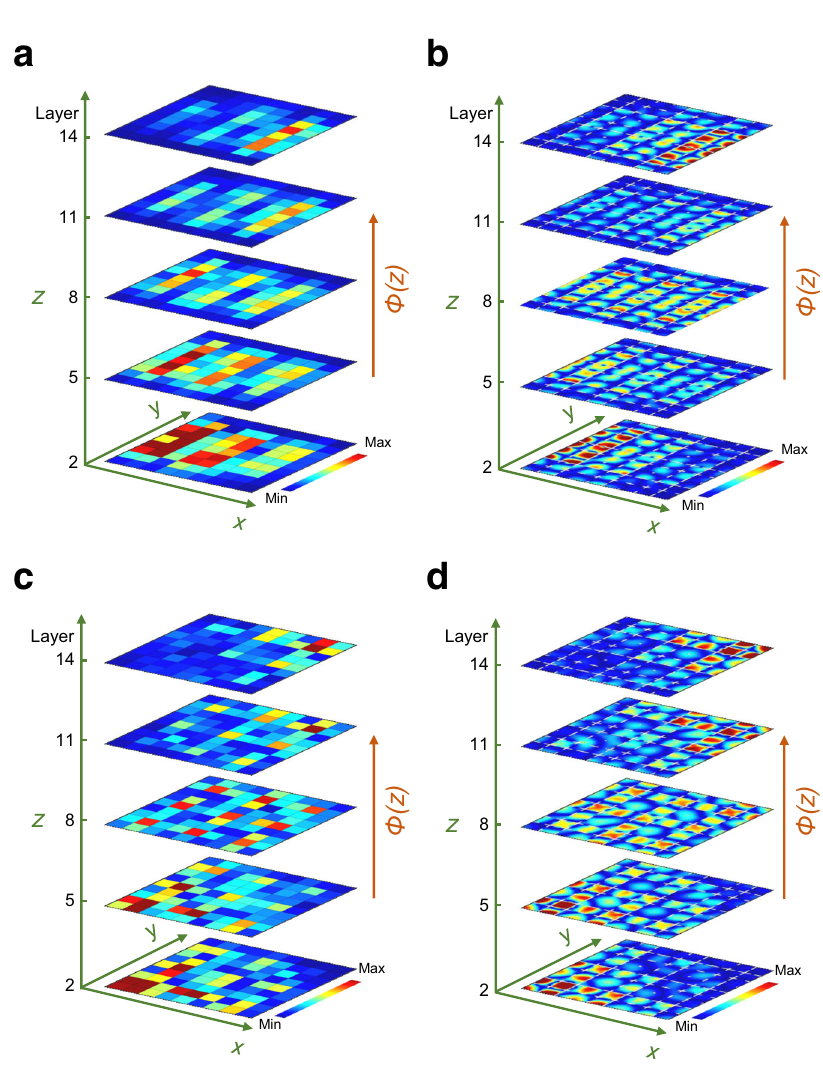
Fig. 3 Topological pumpings in the 3D channel-modulated acoustic crystal. a , b Experimental a and numerical b observation of edge-bulk-edge pumping. The sound is injected at the bottom-left edge with the frequency at f ¼ 7498Hz. c , d Experimental c and numerical d observation of corner-bulk-corner pumping. The sound is injected at the bottom-left corner with the frequency at f ¼ 6175Hz. Note that the pumping parameter ϕ ð z Þ for each horizontal layer of these samples is evenly distributed from (cid:4) 0 : 2 π to 0 : 2 π along the z -direction. The color scale corresponds to the pressure